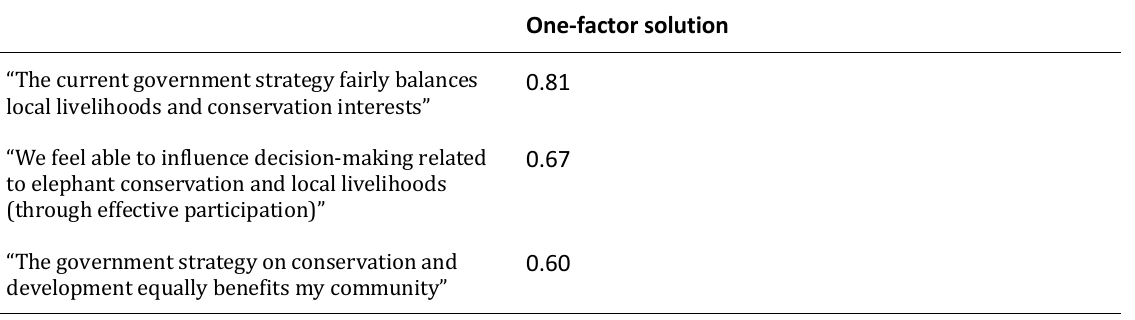
Table A1.1c: Factor loading of the equity